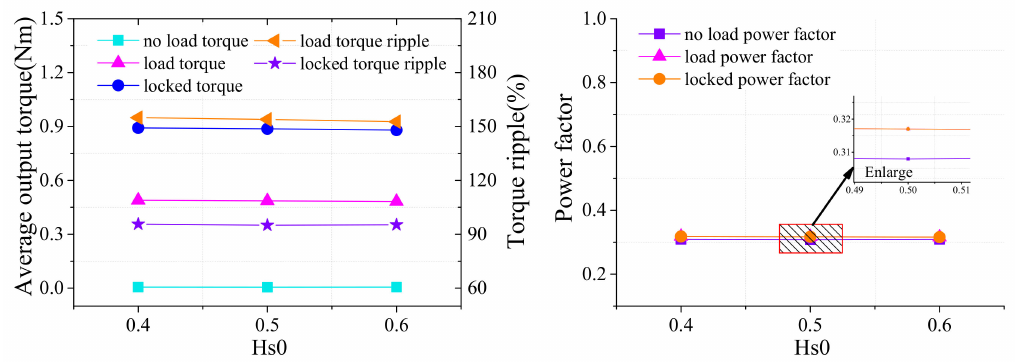
Figure 7. Influence of slot opening height on average output torque and power factor at no load, load, and